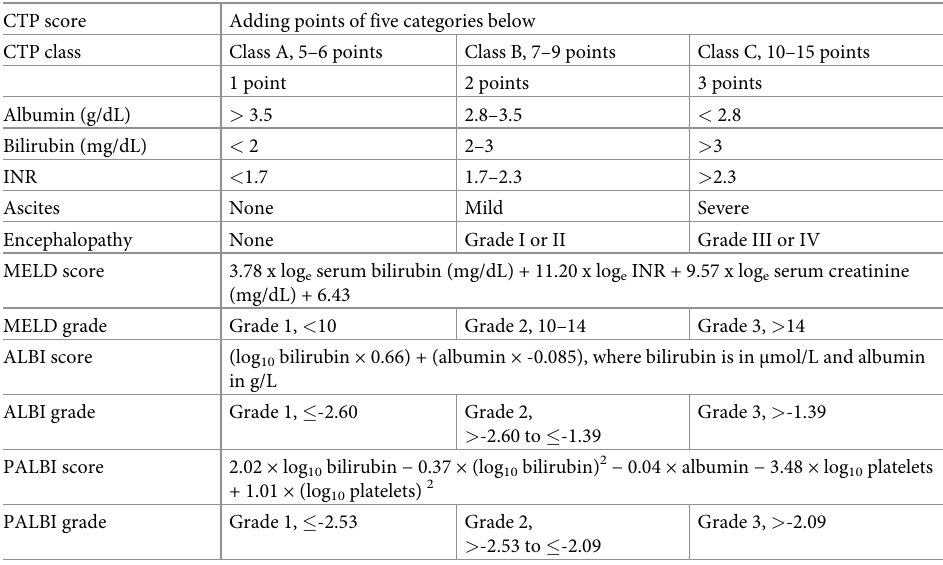
Table 1. Equation for calculating each grade including CTP score, MELD score, ALBI grade and PALBI